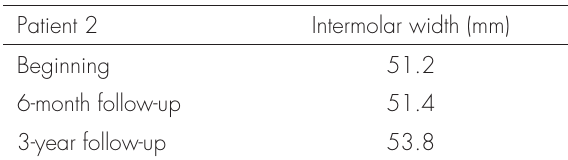
Table II. Study model measurements of the intermolar widths in Patient 2. (Note that the patient had no permanent maxillary canines at the time of space maintainer fitting. Therefore, no intercanine measurements were